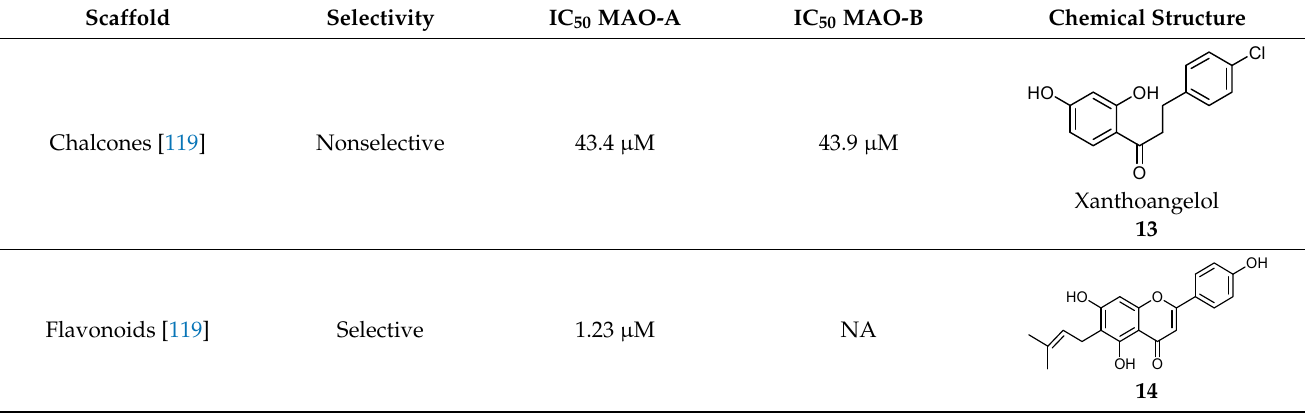
Table 1. The chemical structures of natural and synthetic MAO inhibitors with their IC 50 values. NA stands for not available. Scaffold